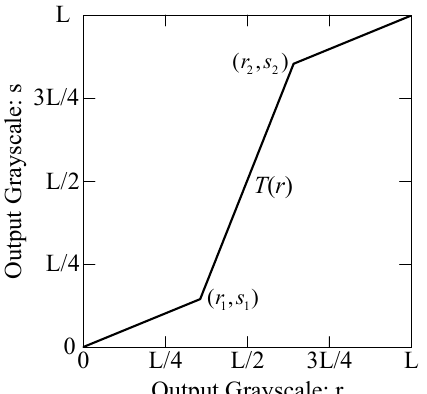
Figure 17. Three-stage linear transformation. As a typical linear transformation, the position of the points can control the shape of the transformation function.